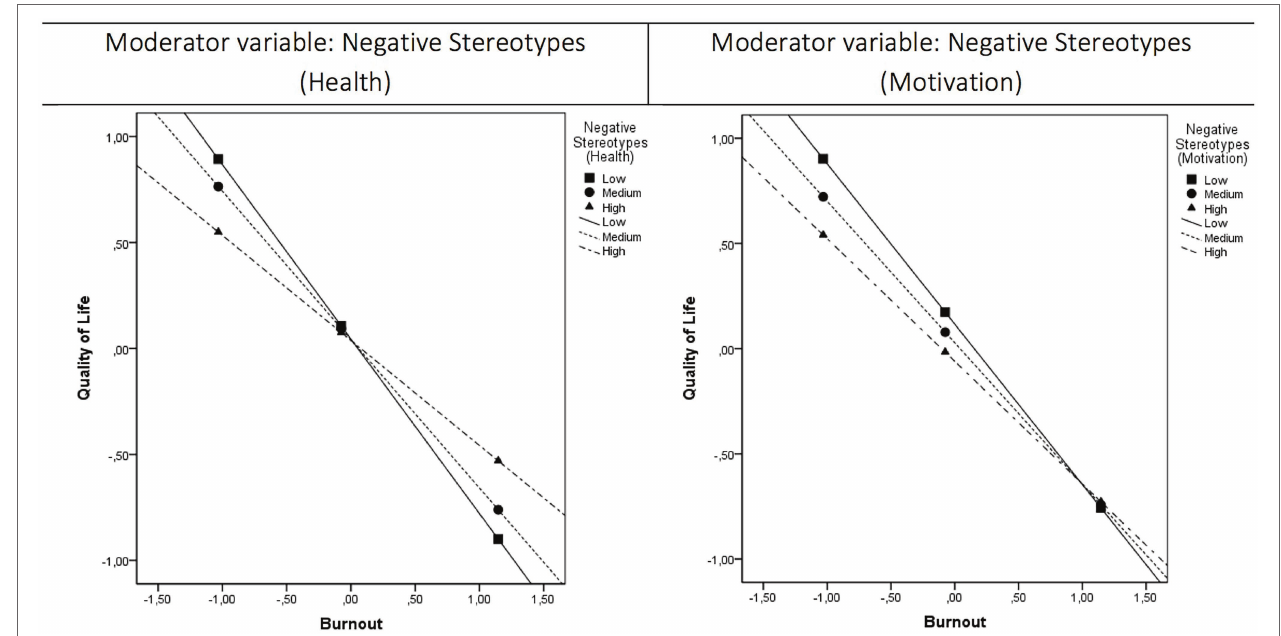
FIGURE 1 | Graphical representation of the moderator effects of negative stereotypes (health) and negative stereotypes (motivation). Moderator effects were estimated using a continuous variable for negative stereotypes, but it was categorized in three groups (low, medium, and high negative stereotypes) using the PROCESS macro v35 for SPSS software to ease the interpretability of the moderator